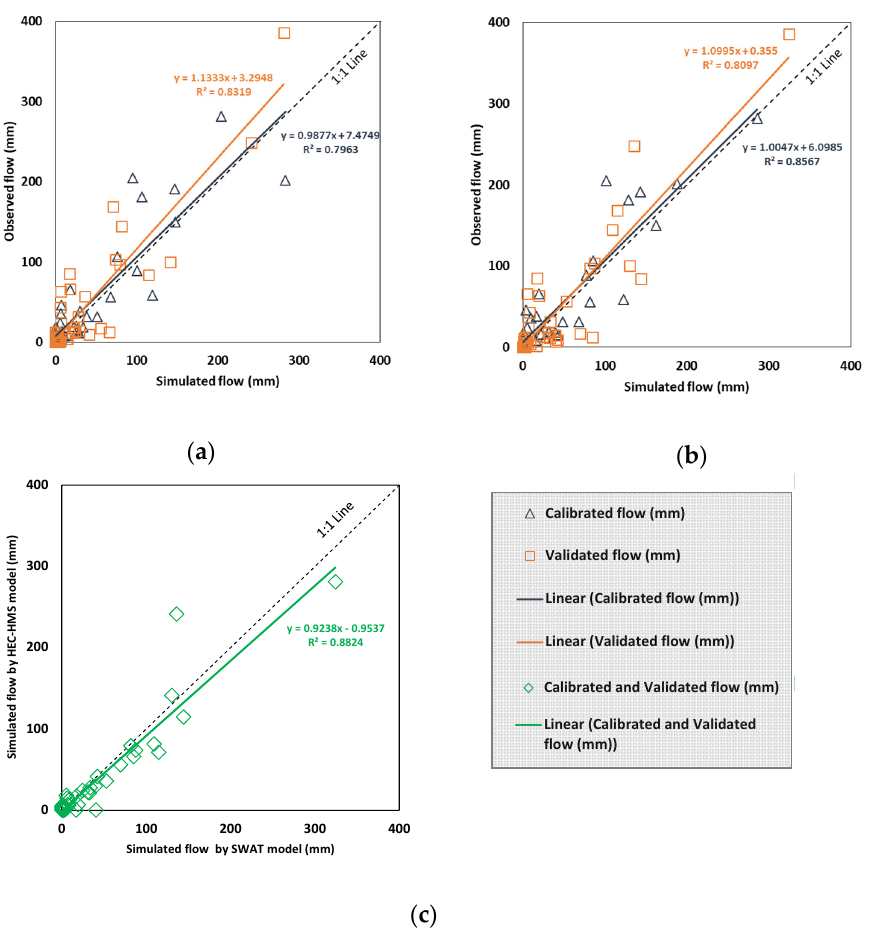
Figure 6. Scatter plots for monthly data comparing between: ( a ) simulated streamflow by HEC-HMS model versus observed streamflow in mm for calibration and validation; ( b ) simulated streamflow by SWAT model versus observed streamflow in mm for calibration and validation; ( c ) simulated streamflow by SWAT model versus simulated streamflow by HEC-HMS during the 2007-2014 period.